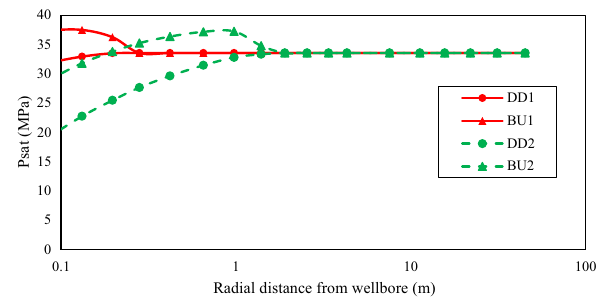
Fig. 7 Saturation pressure profile for flow periods at the end of draw- down and buildup tests (case